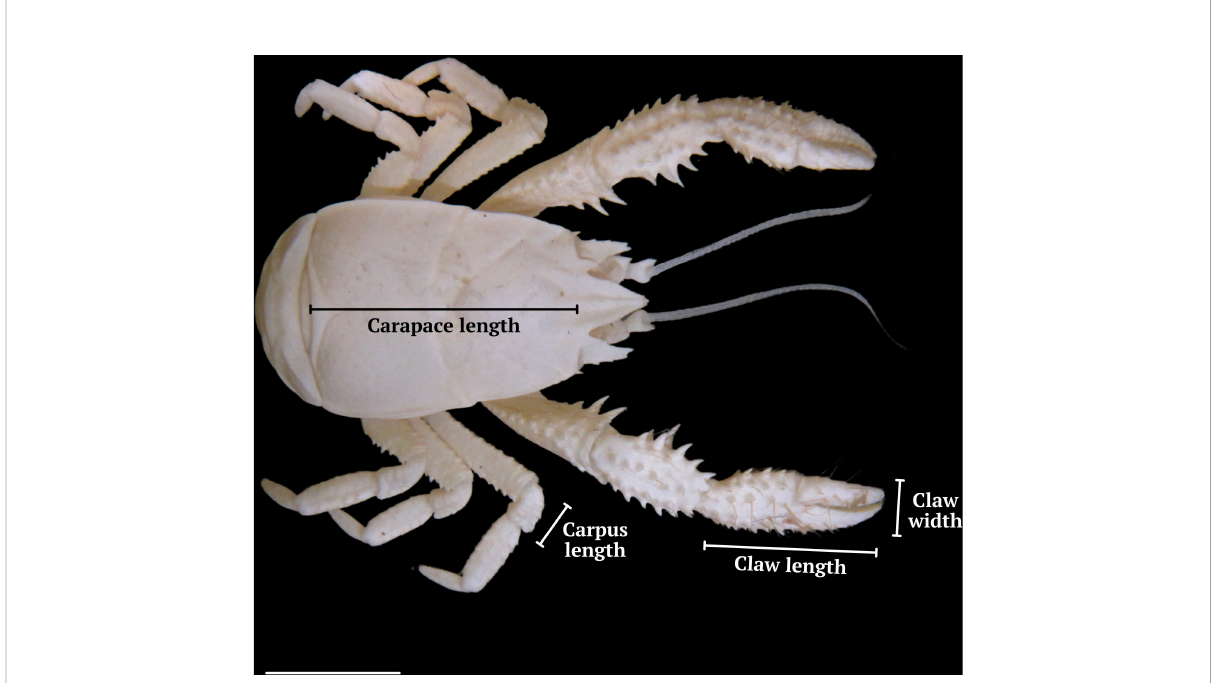
FIGURE 2 Morphological measurements of carapace length, claw length, claw width, and carpus length of the second pereopod in specimens of Kiwa puravida from Mound 12, Costa Rican Paci fi c margin. Scale bar: